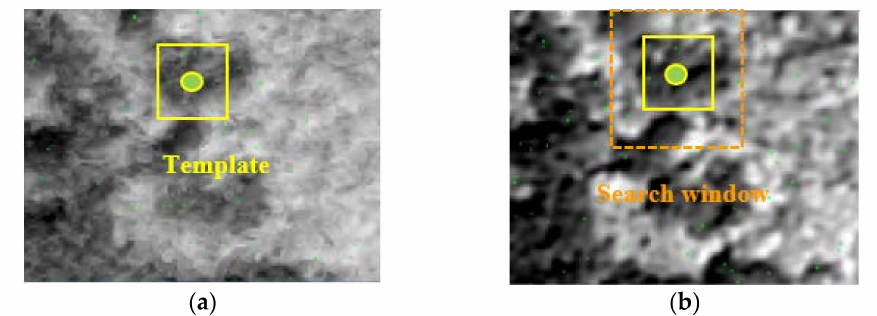
Figure 5. Template matching optimization based on the similarity of the local region where the matching inner point is located. ( a ) Local area of reference image (taking a stable feature image as an example, size 90 × 120 pixels). ( b ) Local area of sensed image (90 × 120